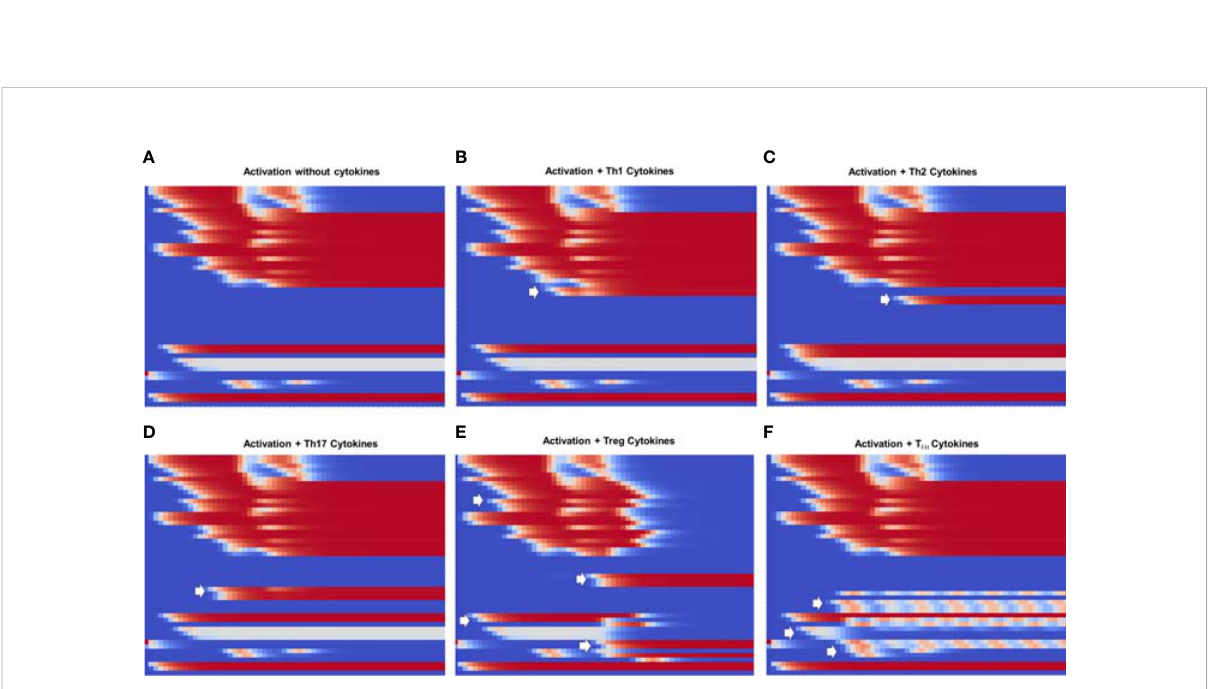
FIGURE 5 Heat map of the dynamics of CD4 + T cell activation and differentiation in the presence of exogenous cytokines inducing either Th1, Th2, Th17, Treg or T FH phenotypes. The order of nodes and colors correspond to those shown in Figure 4. For comparison, we present activation in the absence of exogenous cytokines (Figure A). We observe that (B – D) Th1, Th2 and Th17 display the same glycolytic pro fi le shown in (A) . In contrast, (E) Treg shows an initial transient glycolytic state, afterwards displaced by a high-level oxidative metabolism. (F) T fh exhibits a periodic metabolic pattern alternating between OXPHOS and glycolysis. White arrows indicate activation of signatures speci fi c for each phenotype: (B) T-bet and IFN- g ; (C) GATA3 and IL-4, (D) ROR g t, IL-17 and IL-21, (E) Foxp3, TGF- b and CTLA-4; (F) Bcl-6, CD40L, IL-21 and